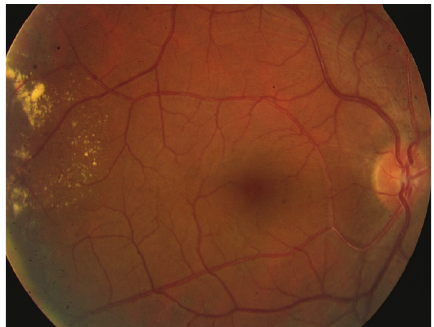
Figure 2: Fundus examination revealed no pathology of the optic disc and macula but severe neovascularization in the temporal peripheral